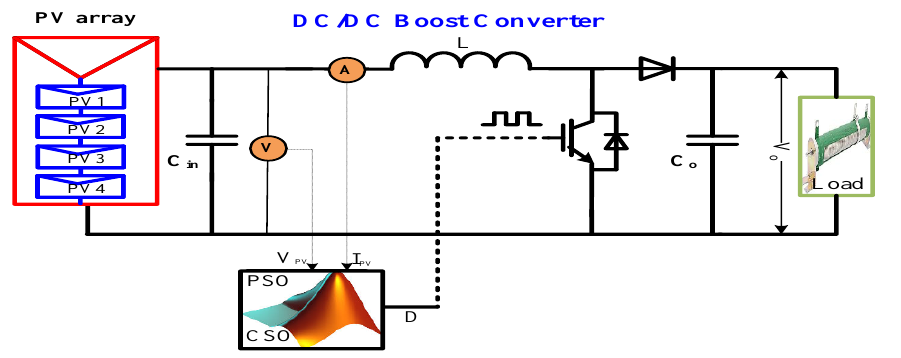
Figure 2. Simulation model of four series-connected PV modules. The inductor/capacitor values are critical in the design of a DC/DC boost converter.